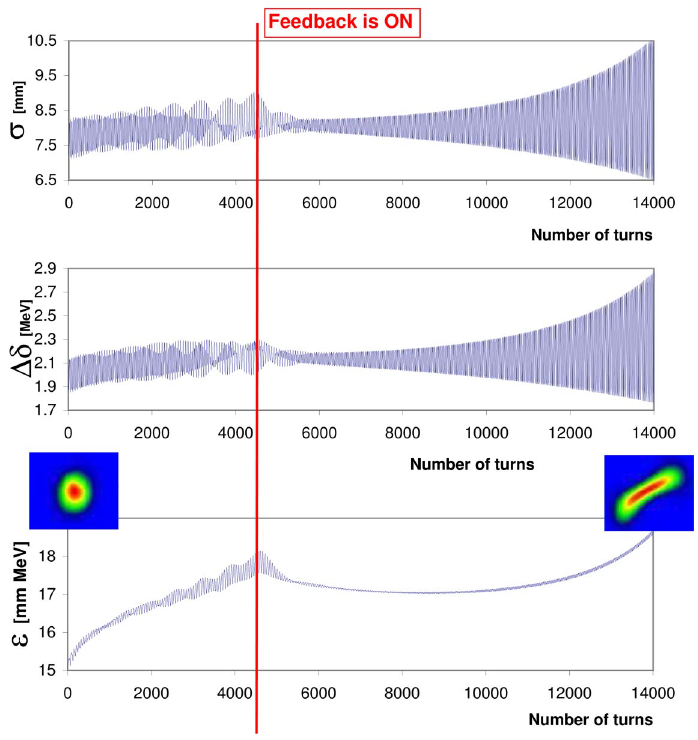
FIG. 10. (Color) Variation of the bunch length (cid:5) , the energy spread (cid:1) (cid:2) , and emittance (cid:10) in time. Results are from the solution of the Fokker-Planck equation with the feedback